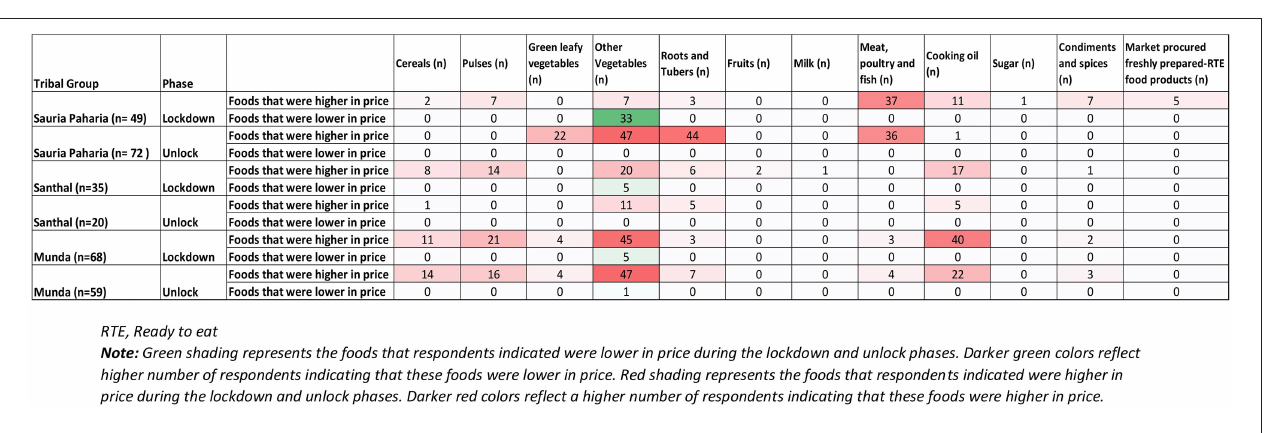
Frontiers in Sustainable Food Systems | www.frontiersin.org